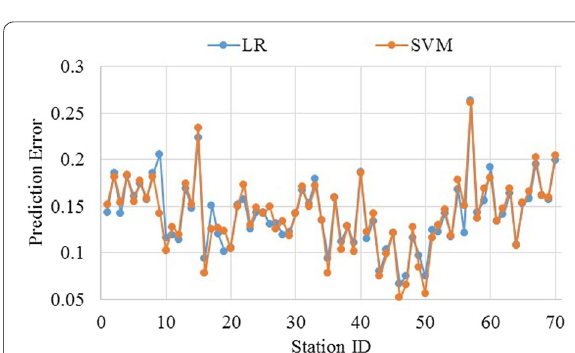
Fig. 9 Comparison of day-ahead prediction error between LR and SVM using CBER. Table 5 in appendix details the empirical